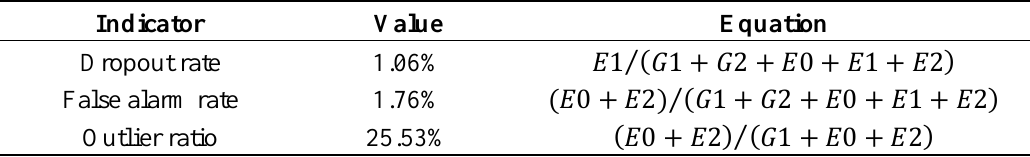
Table 8. Indicators for the performance assessment of target